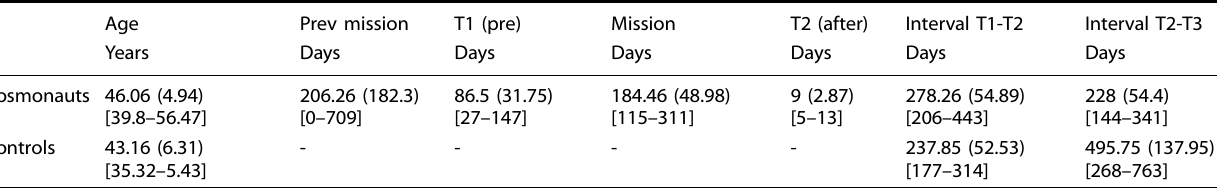
Table 2. Characteristics of the